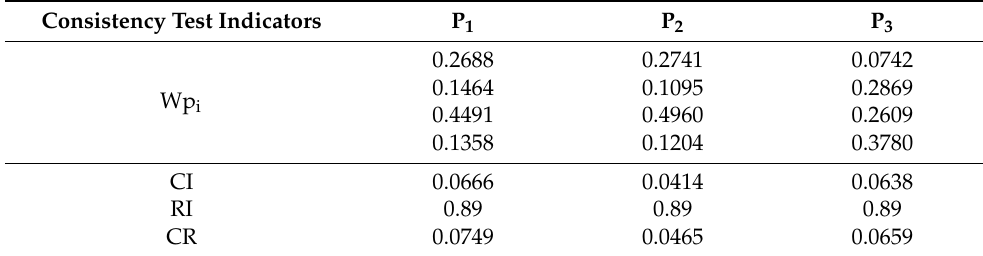
Table 6. Consistency test indicators of the comparison matrix P i